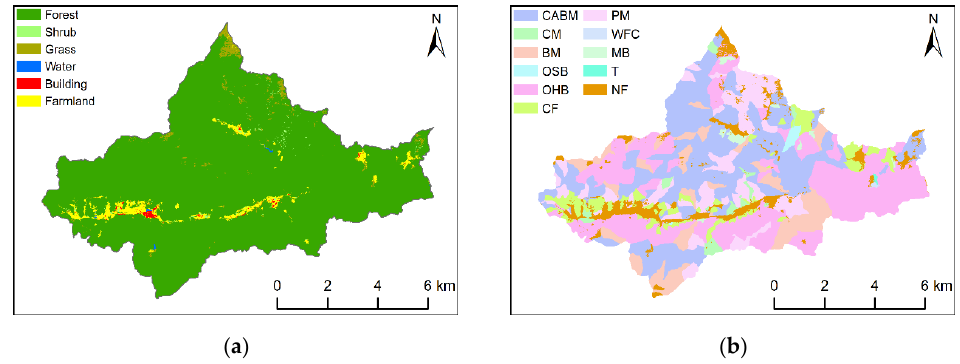
Figure 5. ( a ) Land-use classification map based on GF-1 data; ( b ) forest-types distribution map derived from forestry sub-compartment data and the land-use classification map. Table 3. Areas of different forest types in Chebaling.